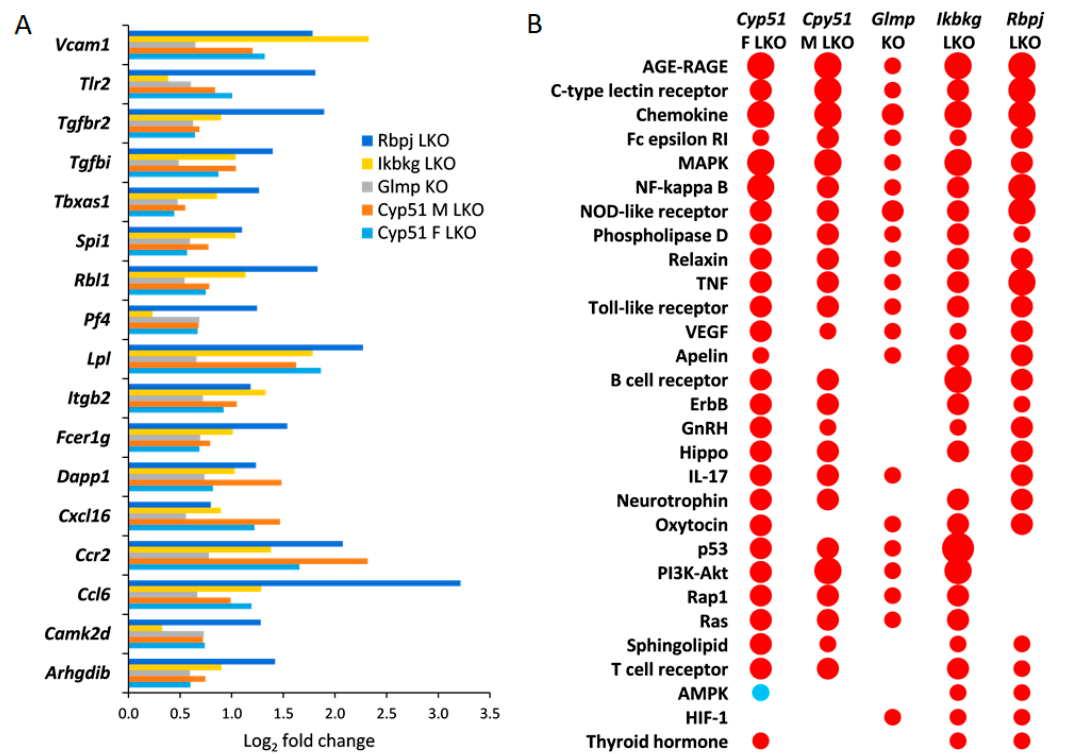
Figure 2. Common significantly enriched Kyoto Encyclopedia of Genes and Genomes (KEGG) signaling pathways and DEGs. ( A ). Log 2 fold change in expression of selected common DEGs in all fibrotic models. Only DEGs, which are a part of common enriched signaling or metabolic KEGG pathways, are presented. Log 2 fold change represents log 2 ratio between average knockout (KO) vs. wild type (WT). ( B ). KEGG signaling pathways common to at least three mouse genetic models of liver fibrosis as calculated using pGSEA (Parametric gene set enrichment analysis)are presented. Red indicates positive enrichment and blue negative. The size of the bubble reflects the fold change of each pathway.